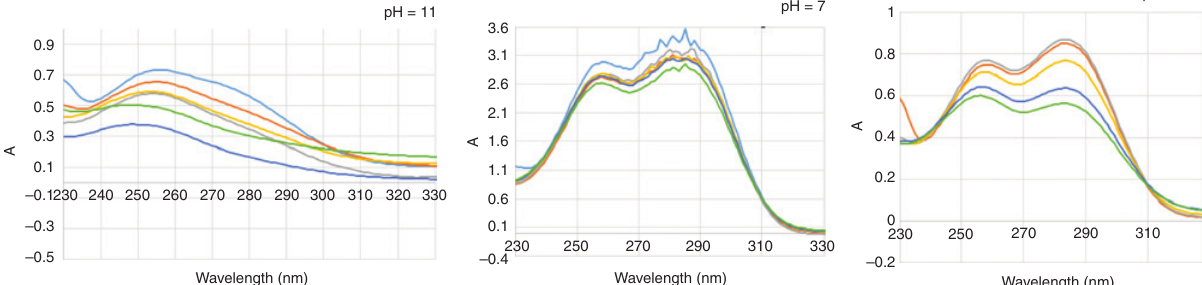
Figure 9: Changes of UV-visible spectra of 30 mgL −1 aqueous solution of STZ in various pH values during the photocatalytic process of UV/CdO with an irradiation time of 0–90 min.